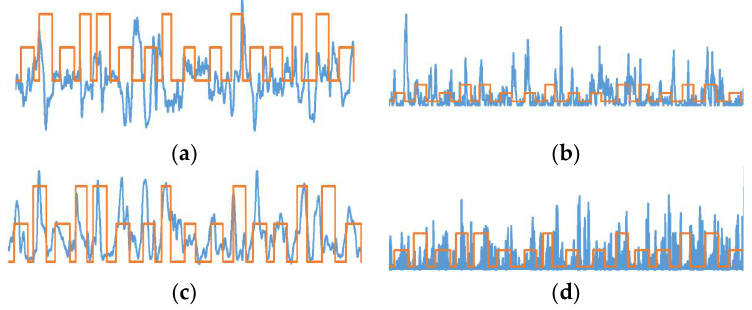
Figure 5. Feature plots for channel selection. ( a ) Movement-related cortical potential (MRCP); ( b ) delta band power; ( c ) RMS; ( d ) alpha band power.